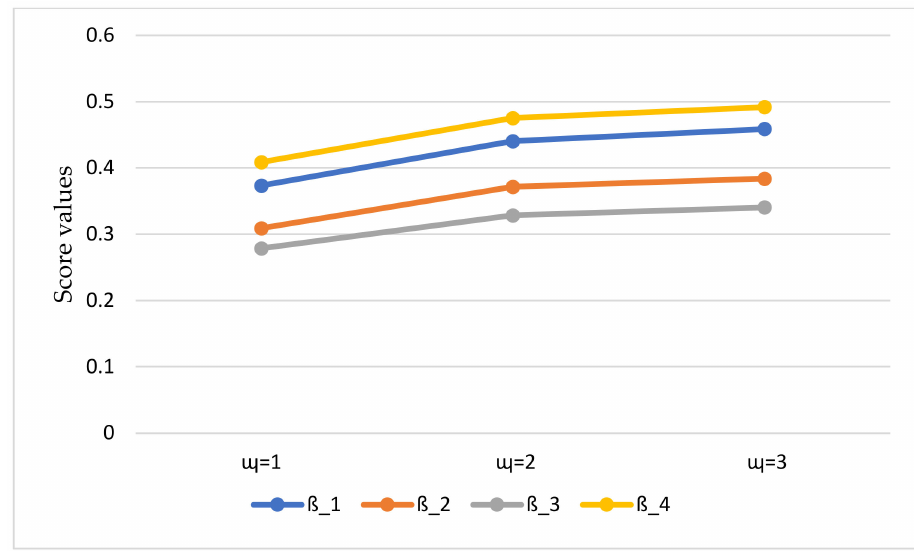
Figure 3. Results of the CPFWHM operator for different values of